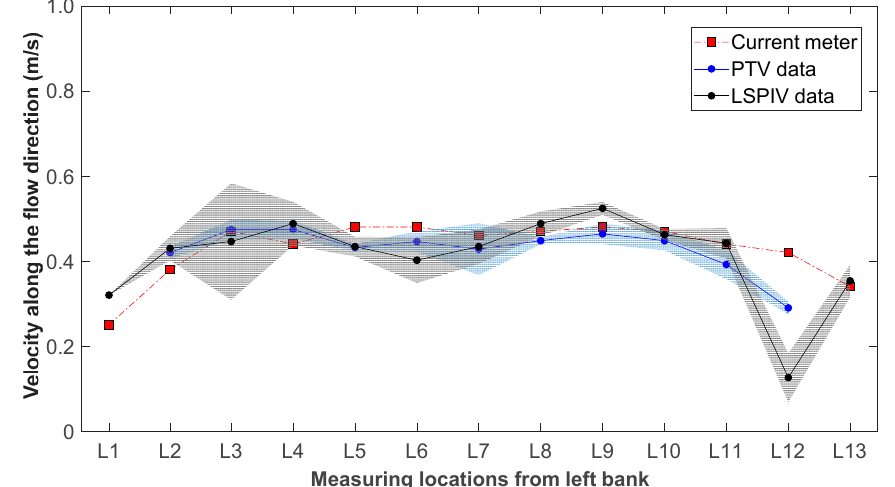
Figure 7. Comparison between surface velocity estimation computed with PTV (blue line) and LSPIV (black line) for experiments carried out in the Noce River at different frame windows. Shaded regions indicate standard deviations between frame sequences. Values recorded with the current meter are indicated by red squares.